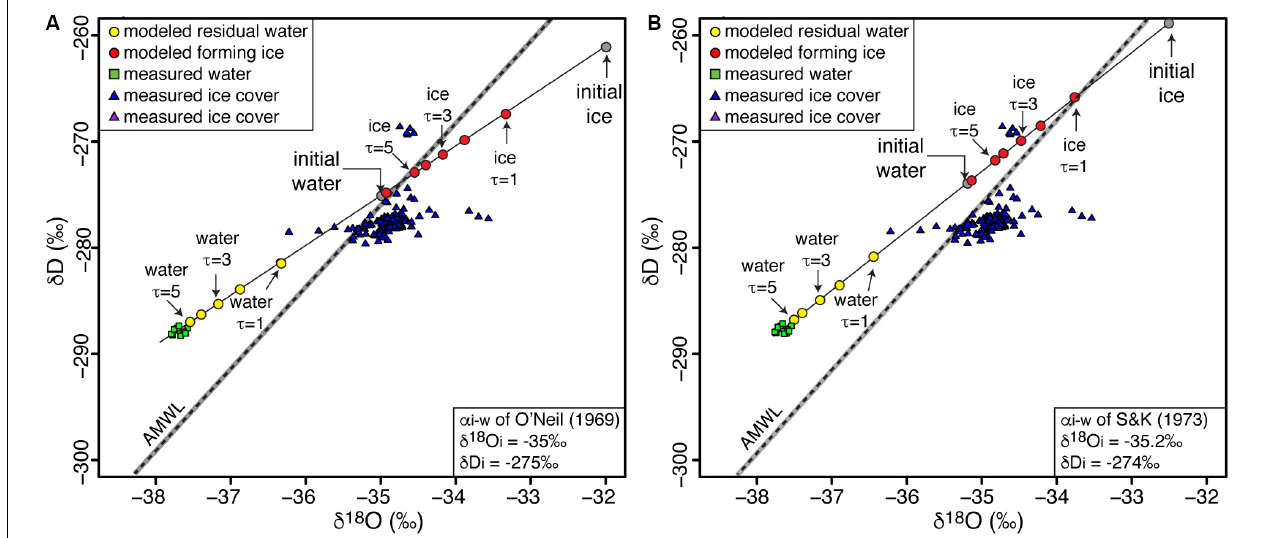
FIGURE 5 | Modeled δ D- δ 18 O composition of Lake Untersee and its ice cover using (A) O’Neil’s (1968) and (B) Suzuoki and Kimura’s (1973) fractionation factors. AMWL, Antarctic Meteoric Water Line ( δ D = 7.75 δ 18 O – 4.93; r 2 = 0.99); gray bar represents 99% confidence interval. See Table 1 for values of input parameters used in